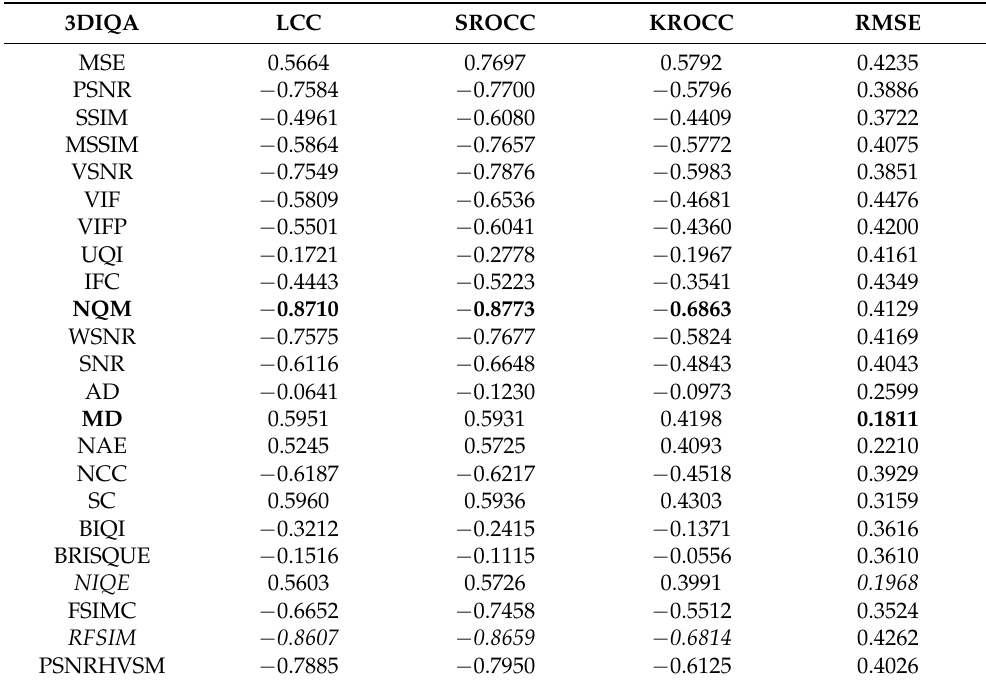
Table 2. Performance across 3DIQA Set in predicting perceived stereoscopic image quality: Linear- Linear Correlation Coefficient (LCC), Spearman’s Rank Ordered Correlation Coefficient (SROCC), Kendall’s Rank Ordered Correlation Coefficient (KROCC), and Root Mean Squared Error (RMSE). Bold indicates the best metric, while italics indicate the second best.